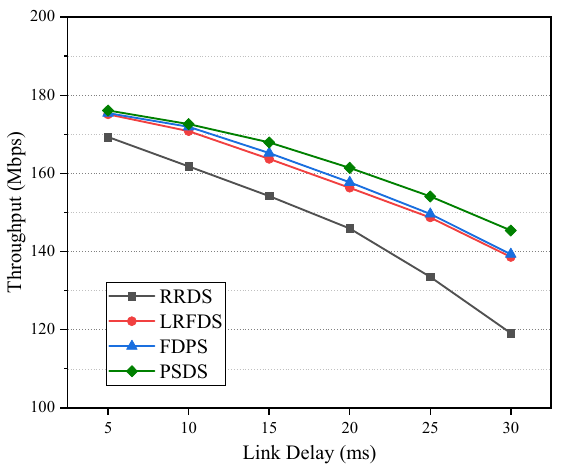
Figure 5. Average throughput under di ff erent link delays.